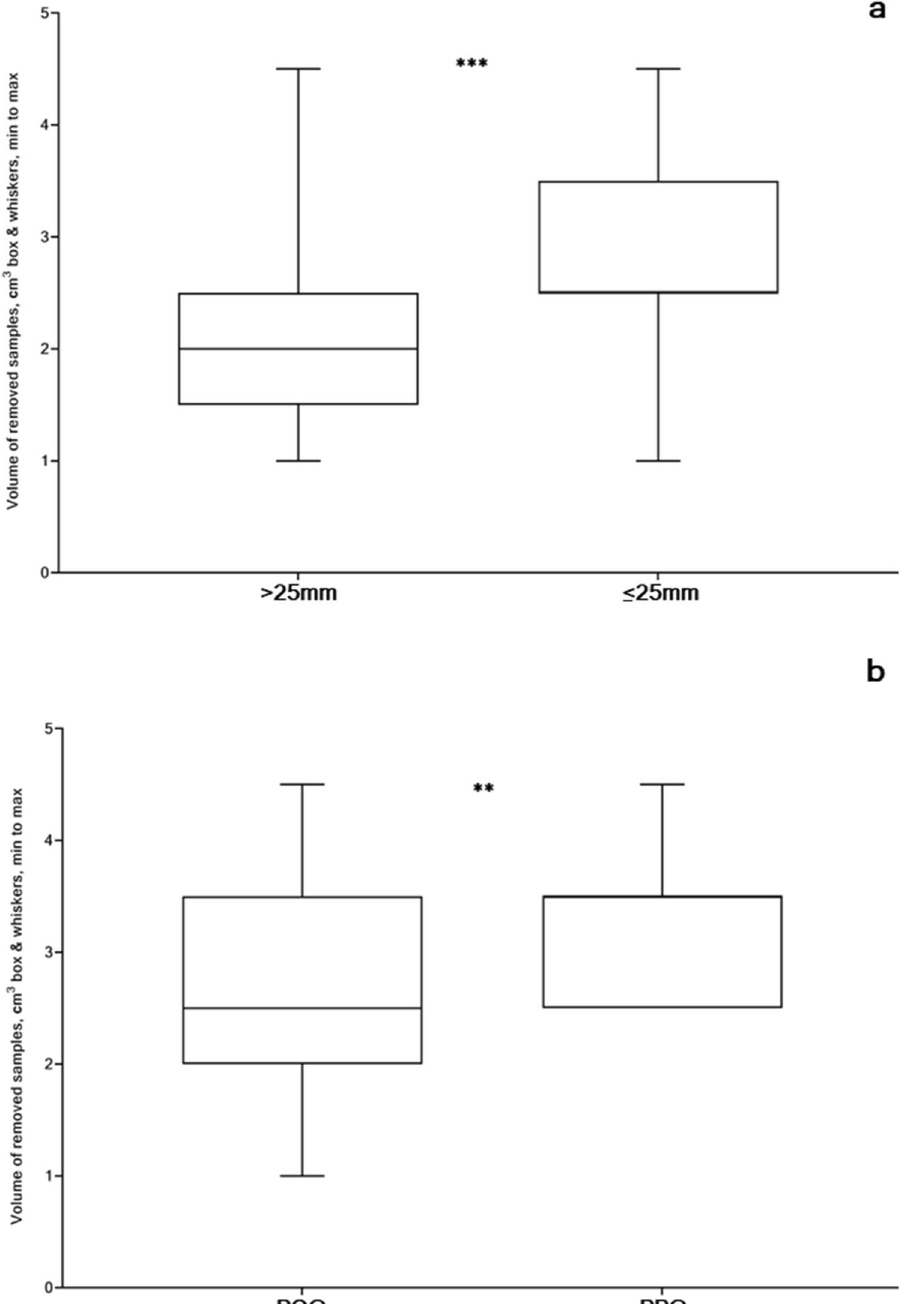
Figure 3. Cervical conization size (unit: cm 3 , box & whiskers, min to max) in asymptomatic women with singleton pregnancies: ( a ) Adequate cervical length (CL > 25 mm) vs Short cervix (CL ≤ 25 mm), groups; ( b ) Progesterone-only (POG) vs Progesterone-Pessary (PPG), groups. p-values were achieved using Mann–Whitney two-tailed t-test with Alpha =